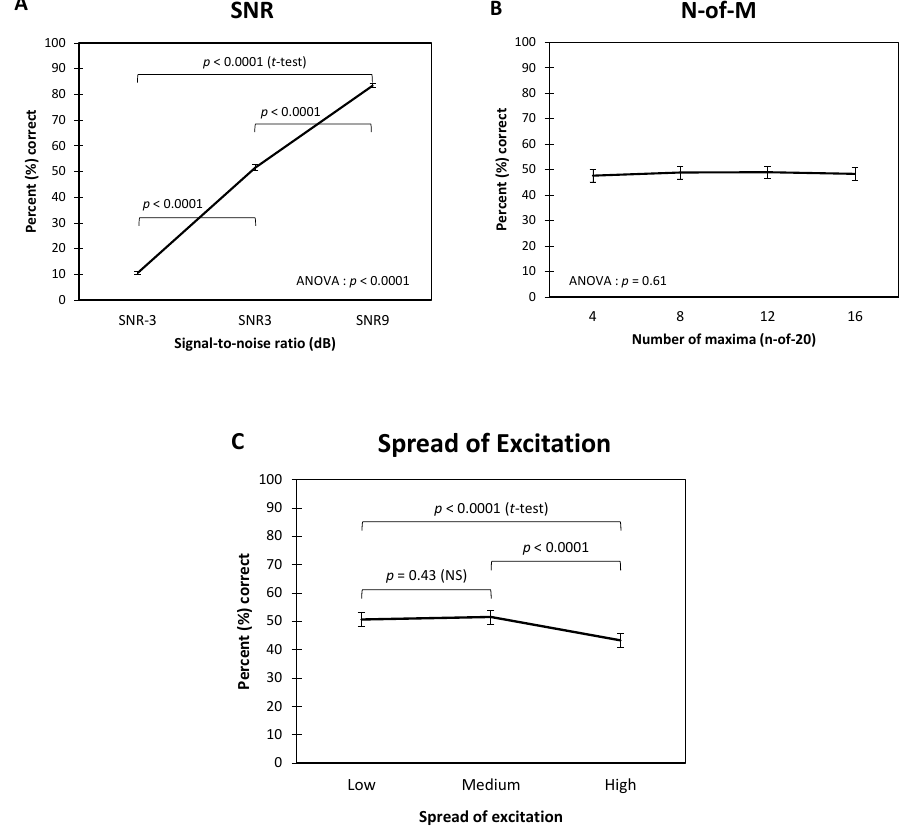
Figure 3. Results of the 3-way repeated measures ANOVA and results of the 2-by-2 comparisons (Student’s t -tests) made on scores transformed in rationalized units (RAU). ( A ) Average syllable recognition scores (in percent correct) across the signal-to-noise ratios. ( B ) Average across the number of maxima. ( C ) Average across the levels of spread of excitation. Error bars represent ± 1 standard error of the mean. Table 4. Average syllable recognition scores for each factor and variation.